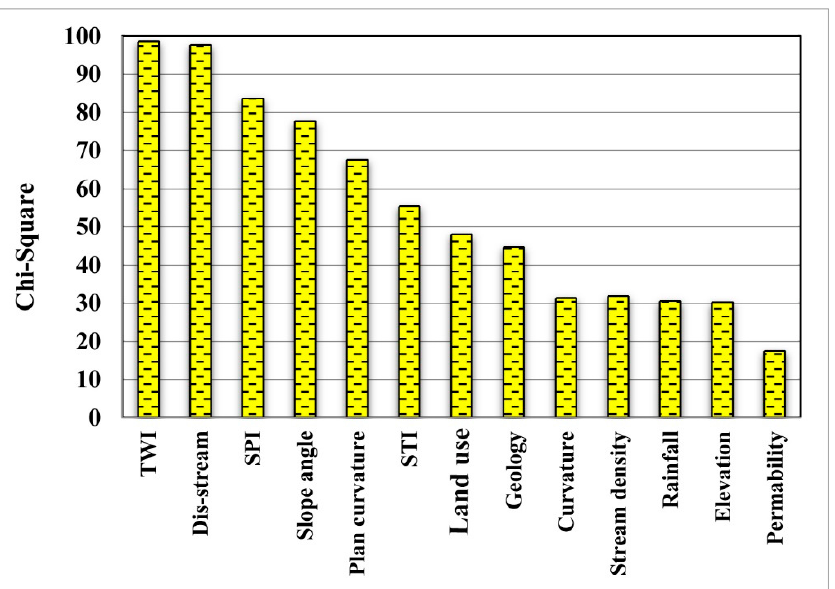
Figure 3. Most effective conditioning factors for groundwater spring potential mapping. Figure 3. Most e ff ective conditioning factors for groundwater spring potential